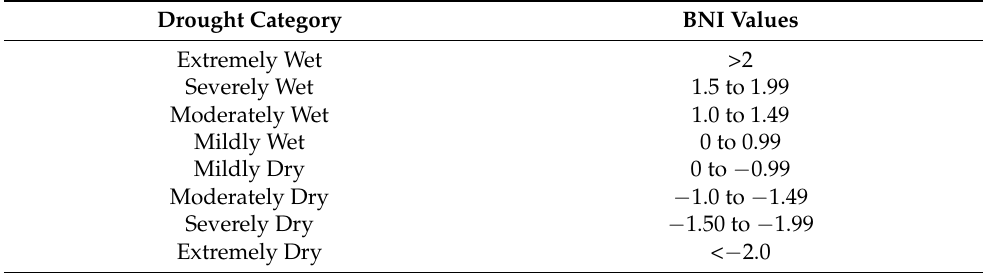
Table 1. BNI drought classification based on SPI.